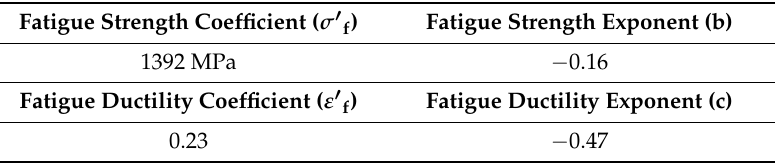
Table 1. Summary of the determined Coffin-Manson